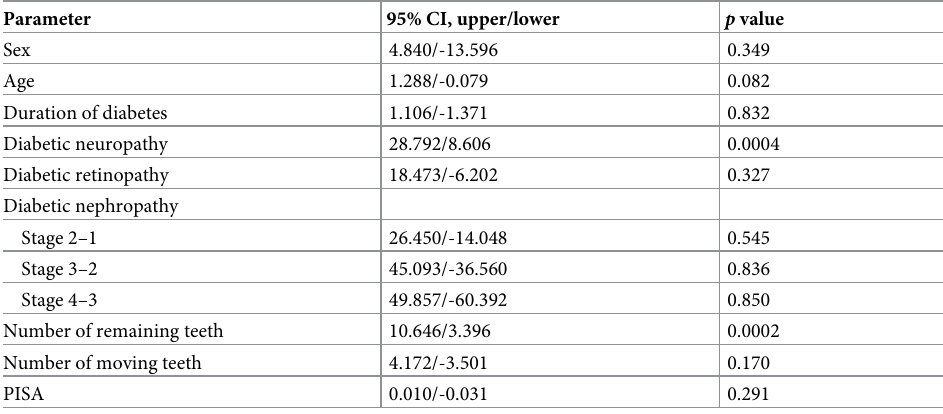
Table 3. Multivariable analysis after